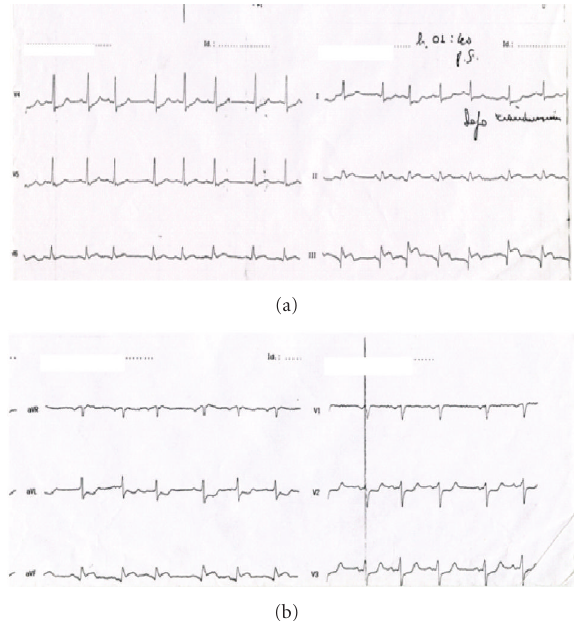
Figure 2: After external cardiac massage and defibrillation we assist to resuscitation with sinus